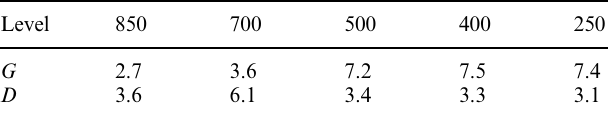
Table 1. Space-time averaged absolute values for dynamic ( G ) and diabatic ( D ) forcings ( · 10 ) 17 hPa ) 1 s ) 3 ) at several mandatory levels (hPa) Level